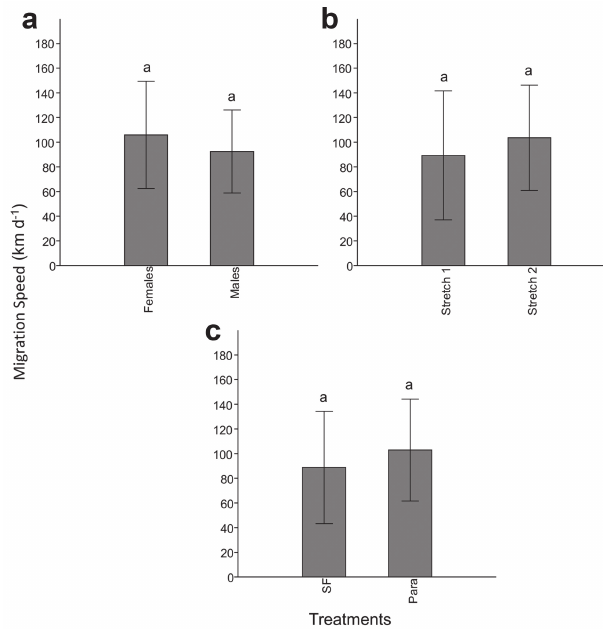
Fig. 4. Comparison of average downstream migration speeds of Prochilodus costatus in the São Francisco River between a. males and females, b. river stretches, and c. fish captured in the Pará River and São Francisco River in S2. Bars represent the standard deviation. Different letters denote significant differences in migration speed. S1 and S2: river